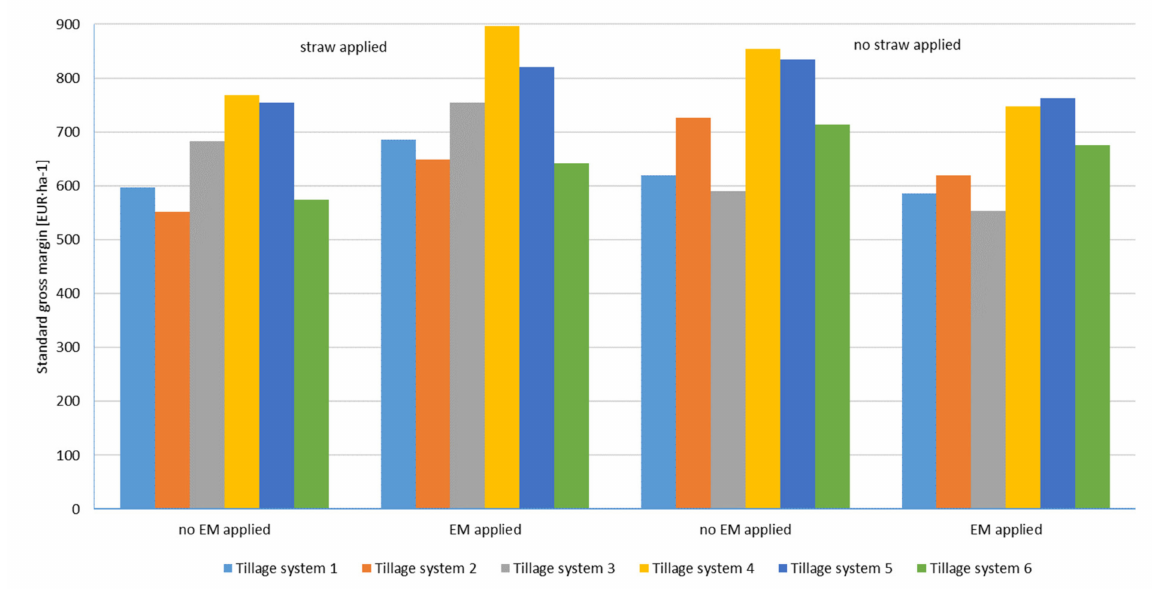
Figure 3. Standard gross margin (EUR · ha − 1 ) spring wheat depending on the tillage method (Factors T and S: see Table